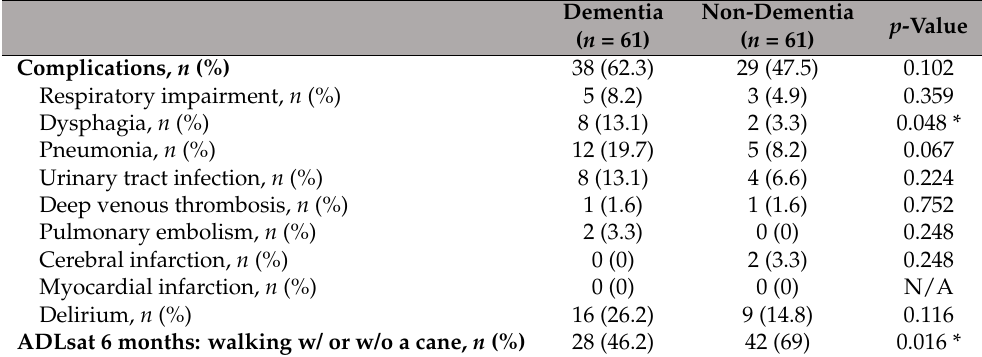
Table 4. Propensity score matching analysis of complications and ADLs after injury.